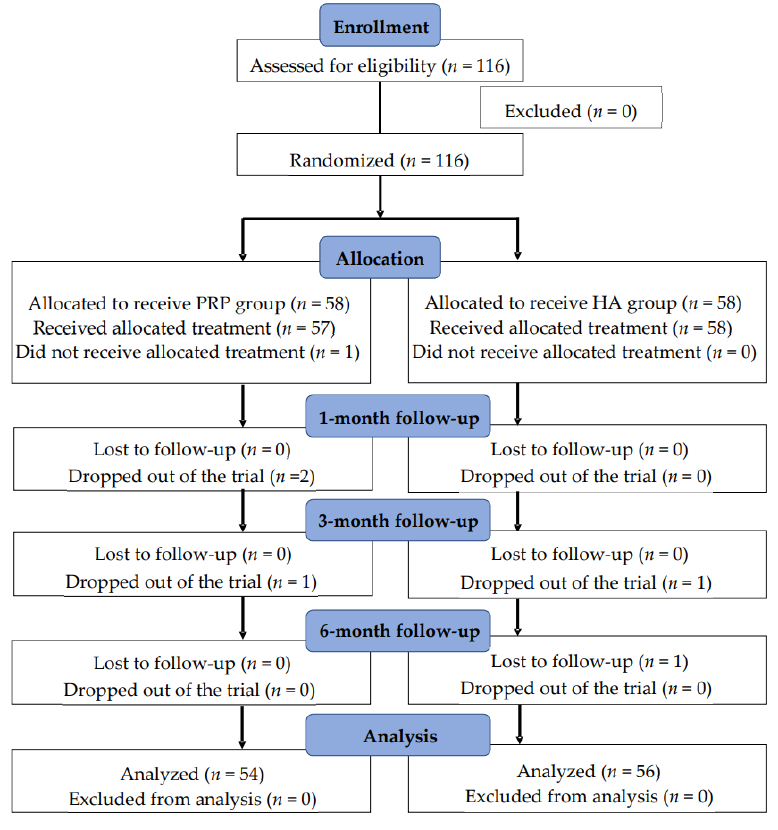
Figure 1. Flow chart of this study. The mean ages in the PRP and HA groups were 61.87 ± 5.46 and 63.00 ± 5.33 years, respectively. Both groups had more women than men (77.8% and 71.4% women in the PRP and HA groups, respectively). Both groups did not differ with respect to age, sex, BMI, K–L grade, treatment side, and WOMAC scores at baseline (Table 1). Table 1. Main characteristics of the included patients in the two treatment groups.